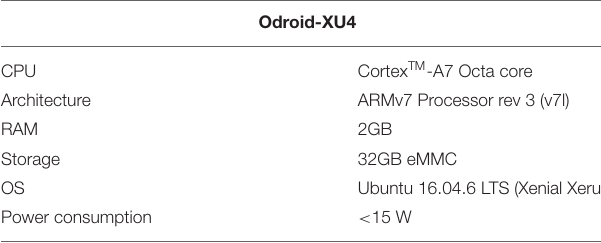
TABLE 1 | Odroid-XU4 board technical